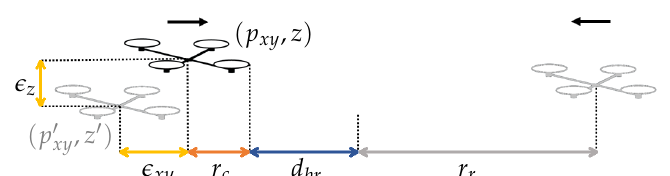
Figure 3. Representation of two UAVs at the instant of starting braking due to an xy-conflict. For the left UAV, the real (black) and measured (gray) positions are represented. The worst case for the maximum positioning error considered in our system is